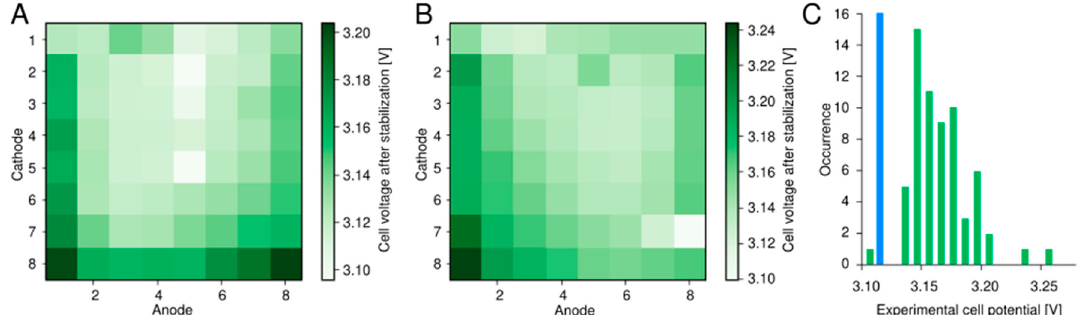
Figure 3. Spatial distribution of cell voltages with cells connected in series ( A ) and the same with both electrolyte flows in reverse direction ( B ). ( C ) shows the distribution of the cell voltages (green) and the theoretical cell voltage of 3.11 V (blue).